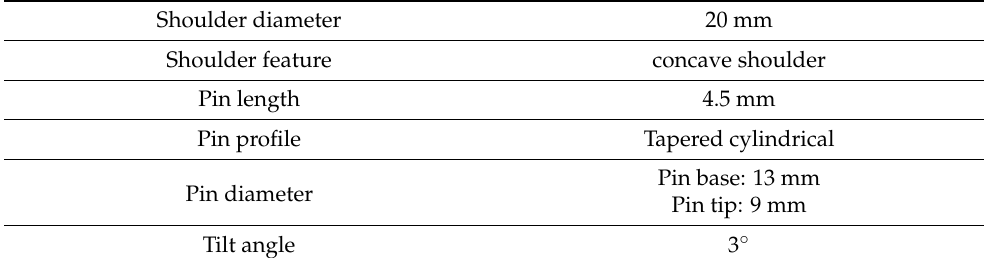
Table 3. Dimensions of the FSW Tool Shoulder and Pin used in this